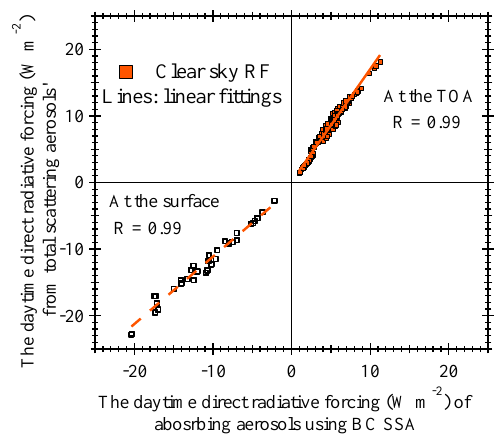
Figure 13. Comparisons in the absorbing aerosol DRFs (Wm − 2 ) between from BC SSA and from the total aerosol DRF minus the scattering